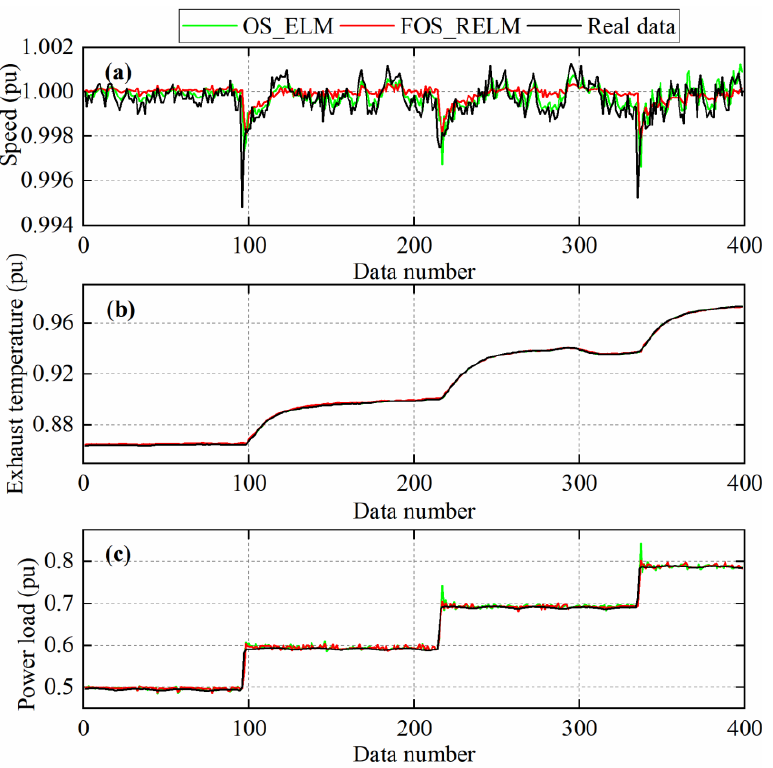
Figure 10. The modeling results with OS_ELM and FOS_RELM: ( a ) Speed signal. ( b ) Exhaust temperature signal. ( c ) Power load signal.